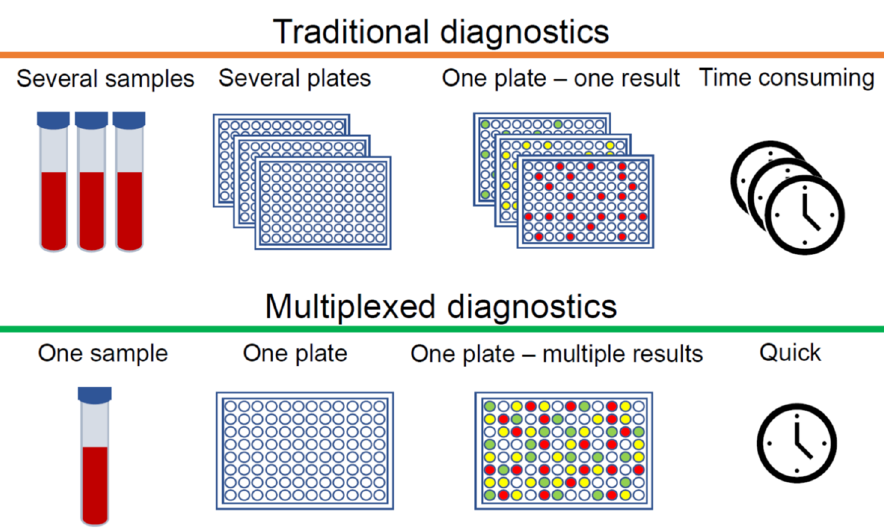
Figure 1. Di ff erences between traditional and multiplexed Figure 1. Differences between traditional and multiplexed diagnostics.